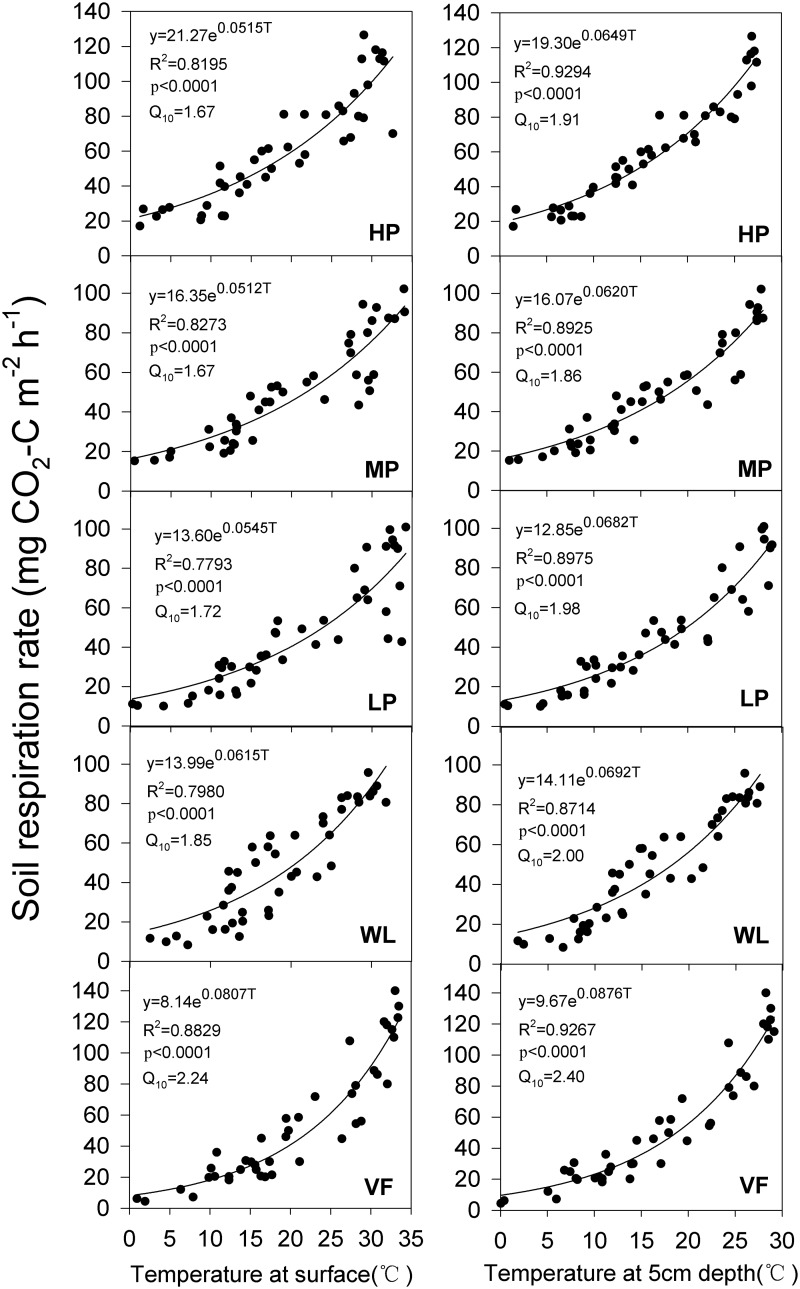
Relationship between the seasonal variation of soil respiration and soil temperature measured at the surface (left) and 5 cm depth (right).HP = tea garden with high production, MP = tea garden with medium production, LP = tea garden with low production, WL = woodland, VF = vegetable field. The data points (n = 43) are the weekly mean of five subplots from each site.